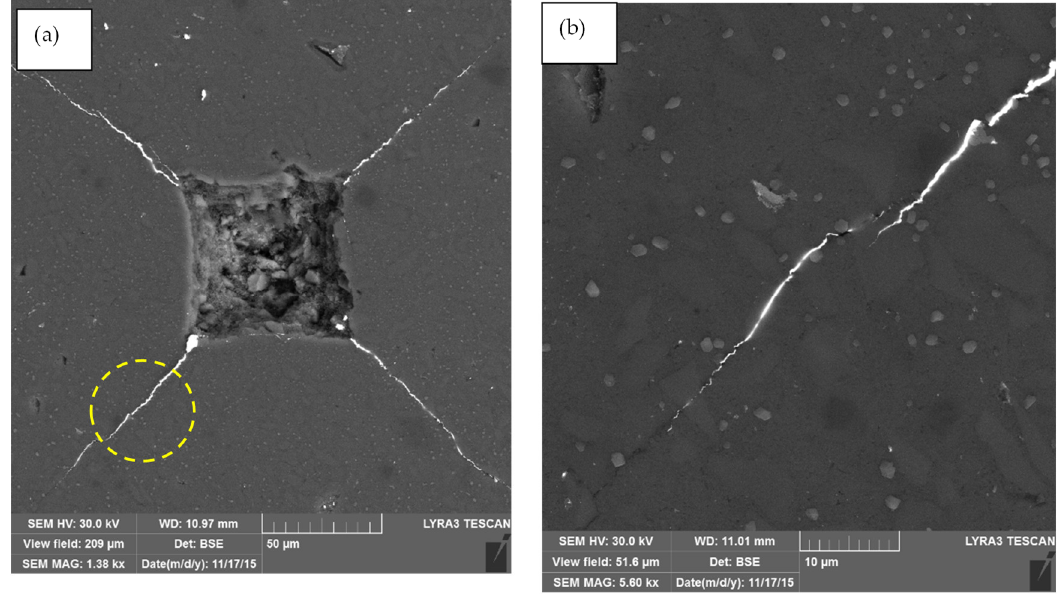
Figure 11. ( a ) FESEM image depicting the crack length and its propagation within 10% SiC/Ca-α- SiAlON composite. ( b ) A close-up FESEM view showing the crack propagation.